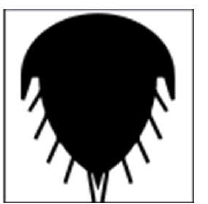
Figure 6 . Trilobite fossil symbol displayed in FontForge font editor.